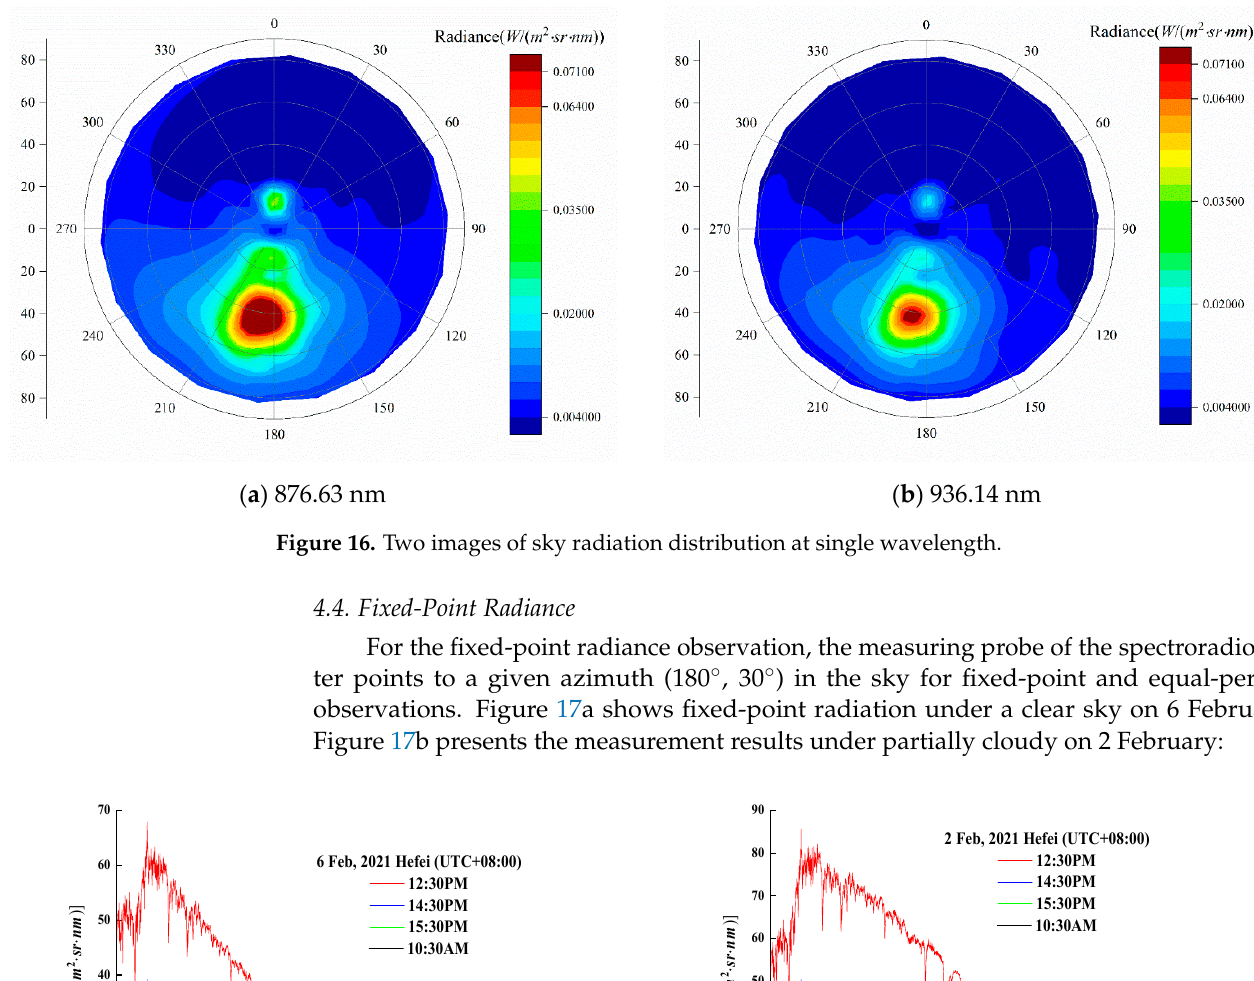
Figure 15. Diffuse-sky radiance distribution at different times during the course of a day. Two images of sky radiance at the single wavelength are illustrated in Figure 16. At the same observation time, the diffuse-sky radiance distributions at different wavelengths have some similarities, but there are various areas with highlighted regions in the distri- bution graph. The single-wavelength background radiance on the absorption band is sig- nificantly smaller than that of its adjacent non-absorption band. For example, the radiance value of 936.14 nm in the water vapor absorption band is an order of magnitude smaller than that of 876.63 nm.